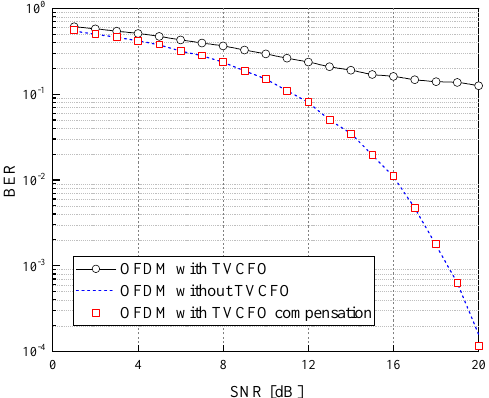
Figure 6. Bit error rate statistics of demodulations in three cases: without CFO compensation, with actual CFO compensation, and with DE estimation values